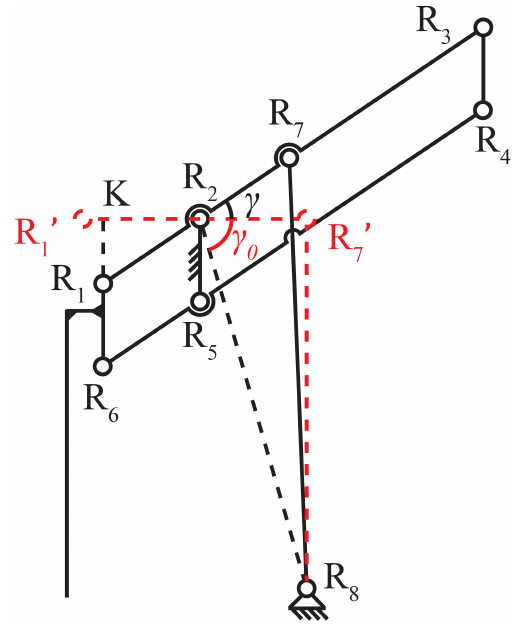
Figure 11. Schematic diagram of the seat module.